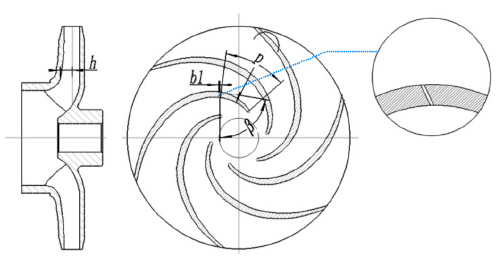
Figure 4. The schematic diagram of the gap geometry parameters.